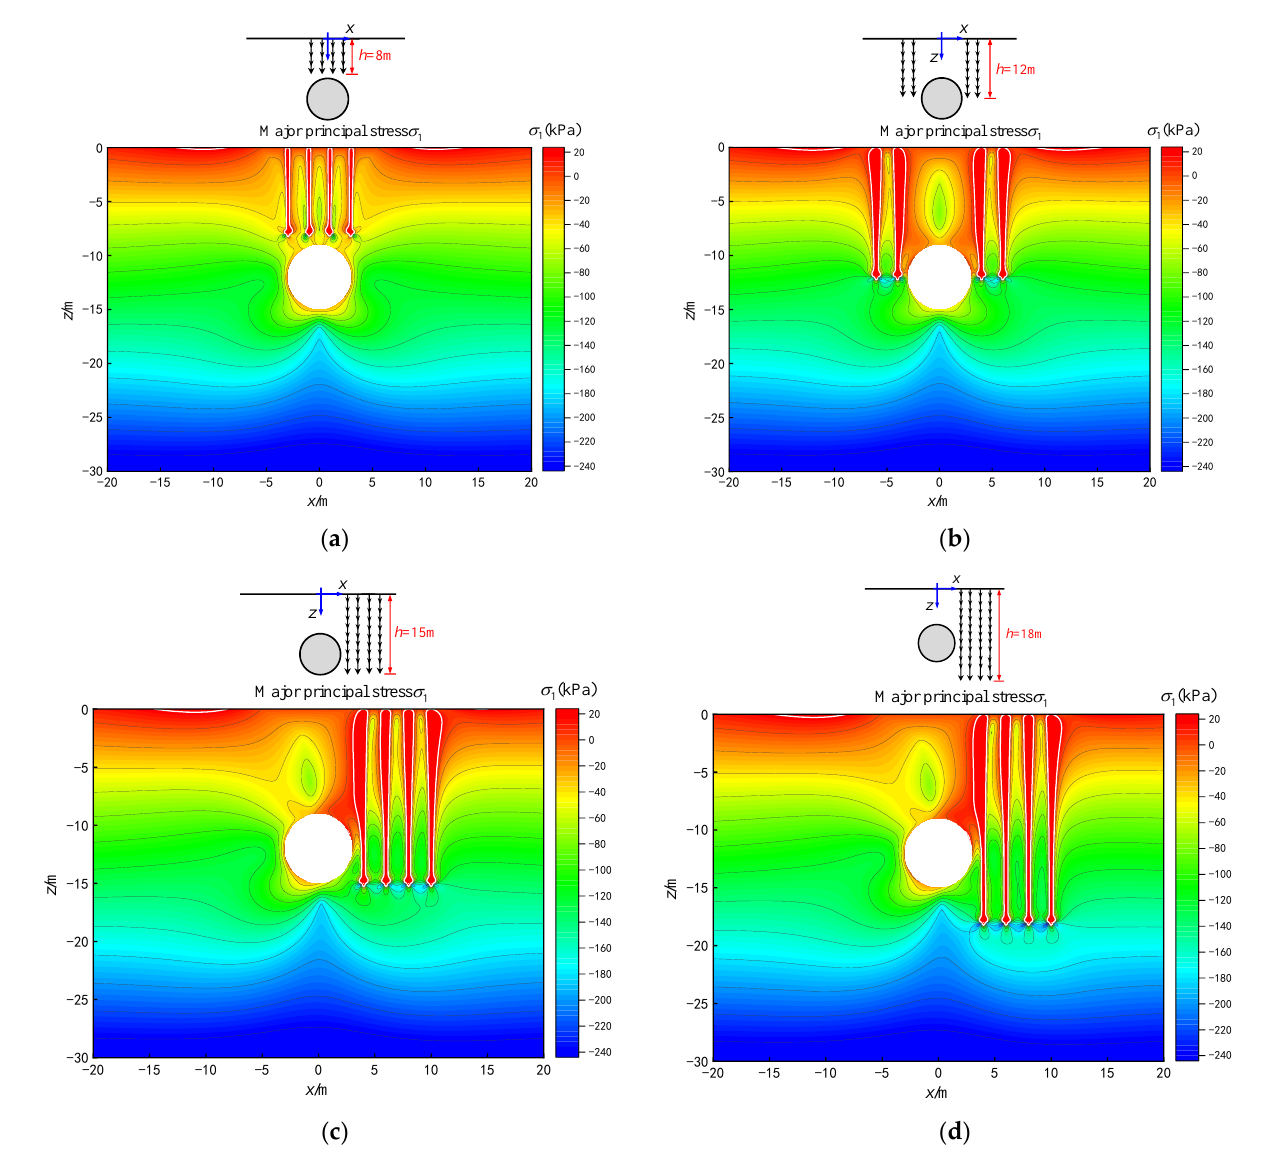
Figure 9. Contour diagrams of major principal stresses with various pile lengths and relative positions of the pile group and tunnel when s r = 0.9: ( a ) the pile group right on top of the tunnel; ( b ) the pile group distributed on both sides of the tunnel; ( c ) the depth of the pile group tip close to the tunnel spring line; ( d ) the depth of the pile group tip deeper than the tunnel spring line.